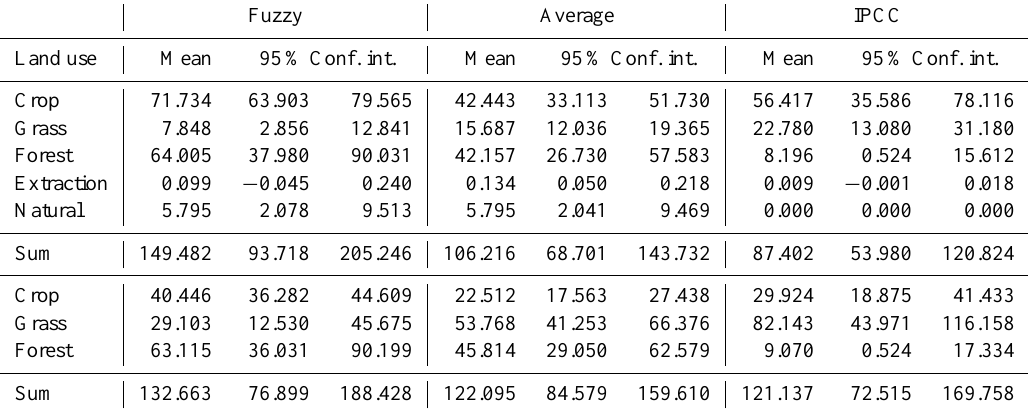
Table 4. N 2 O emission budget for European peatlands from different approaches: fuzzy logic model (Fuzzy), average emission factors of flux data from this study (Average) and IPCC emission factor approach (IPCC) are shown as mean and 95% confidence interval of the budgets in GgN 2 O-Na − 1 . The land use categories are based on CLC 2006 (top) and HILDA 2010 (bottom).